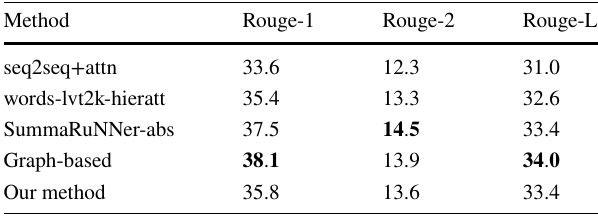
Best results are in Table 7 Performance comparison of various abstractive models on the entire CNN/DailyMail test set using full-length F1 variants of Rouge